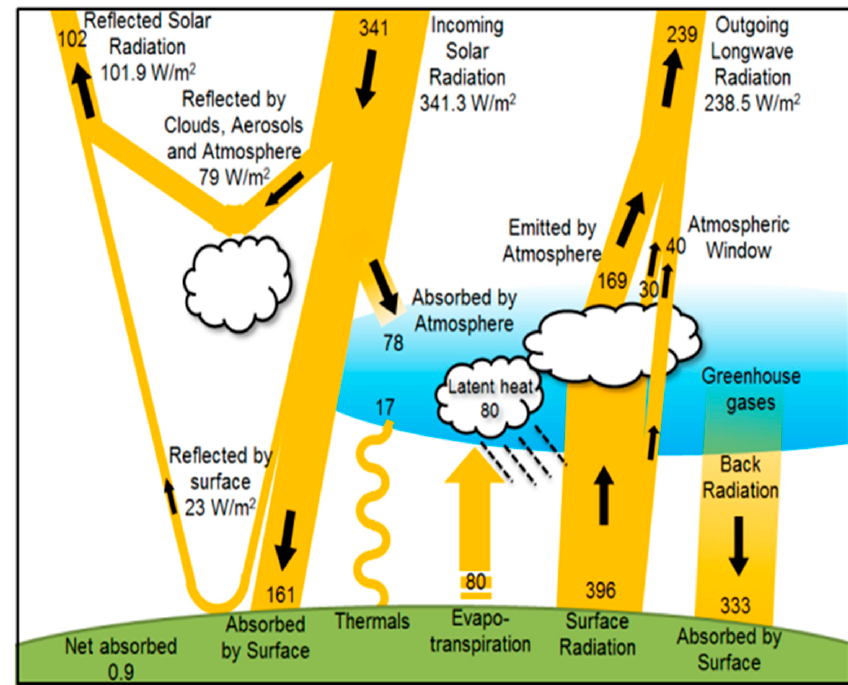
Figure 1. Representation of earth–atmosphere energy balance [24].